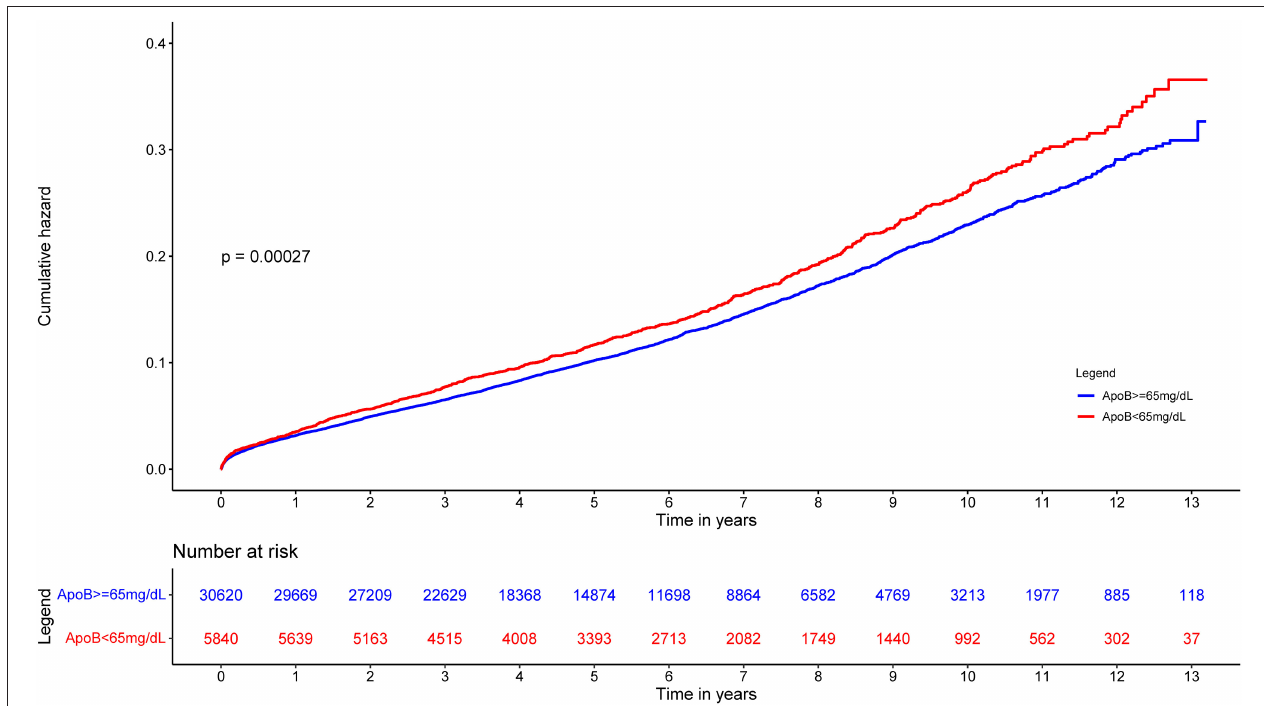
FIGURE 2 | Cumulative incidence of all-cause death for ApoB < 65 mg/dL group vs. ApoB ≥ 65 mg/dL group in CAD